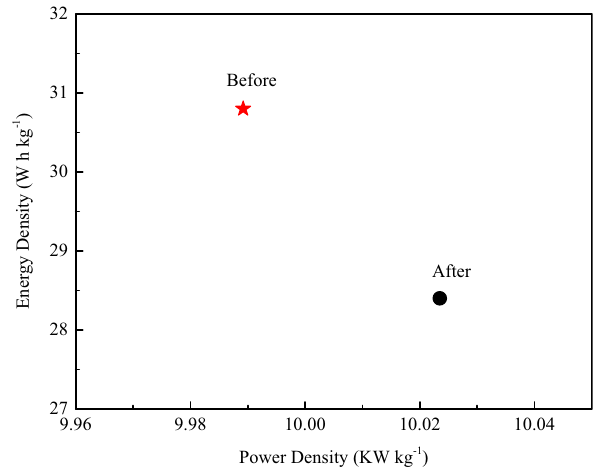
Figure 12. Ragone plots of the supercapacitor before and after stability test.